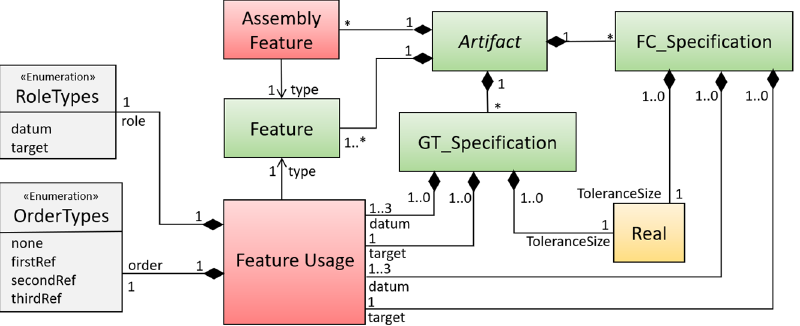
Figure 6. Abstract syntax of feature-based artifact specification (“*” is a “zero to many” multiplicity).